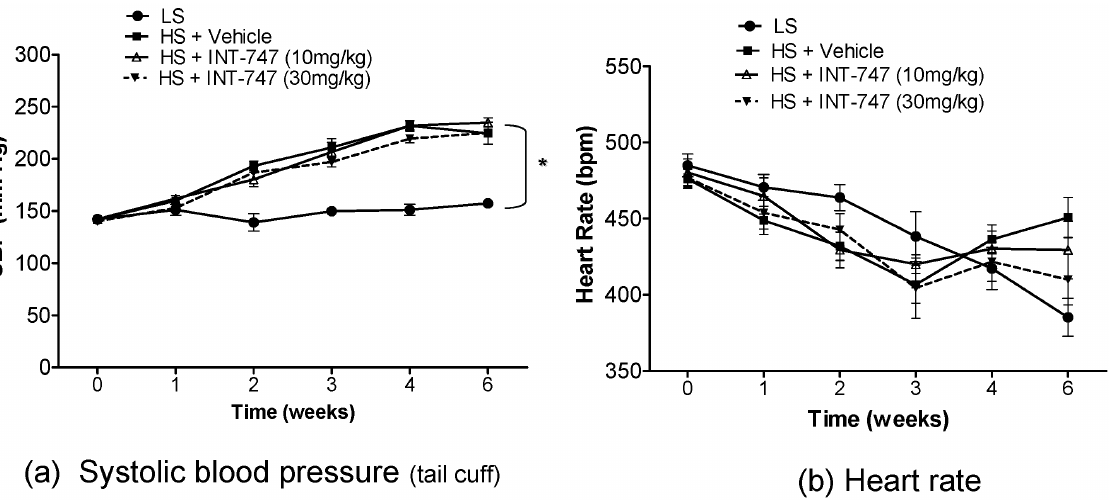
Figure 2. High-salt diet progressively increases systemic blood pressure. Weekly measurement of: a) systolic blood pressure (SBP) and b) heart rate (HR) by tail-cuff in Dahl salt-sensitive rats fed diet containing low salt (n=9); high-salt and treated with vehicle (n=15); high-salt and treated with 10 mg/kg/day INT-747 (n=15) or high-salt and treated with high dose of INT-747 at 30 mg/kg/day (n=15). Data is expressed as Mean 6 SEM. (*p , 0.05 versus high-salt diet data. ANOVA followed by Bonferroni post-test).